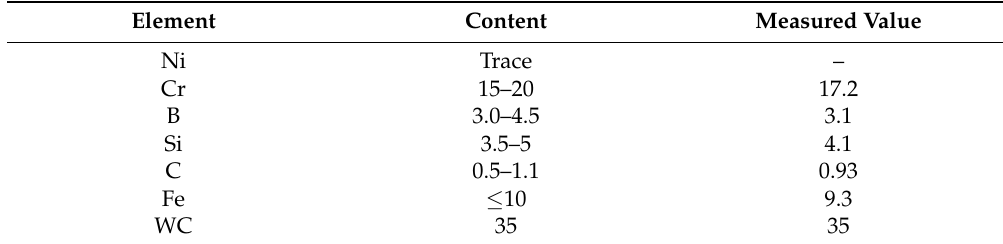
Trace – Table 2. Chemical composition of nickel tungsten carbide powder Ni60 + 35WC (wt %).